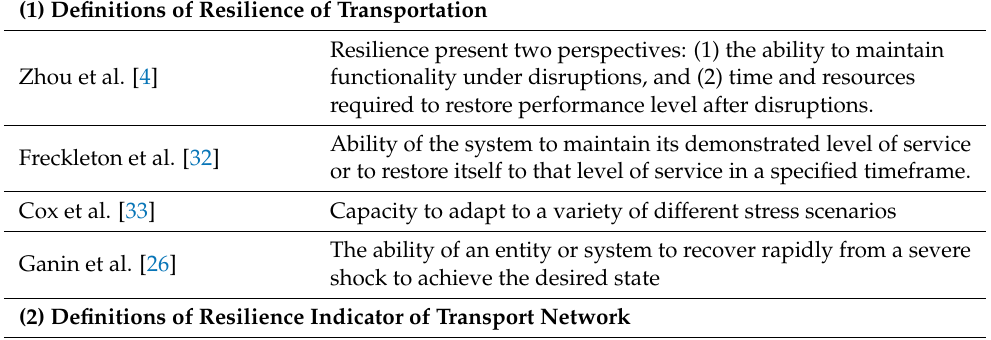
Table 1. Several existing definitions of resilience and assessment indicator on transport